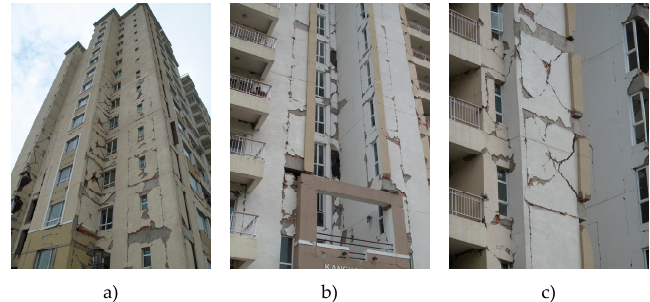
Figure 1. Fourteen-storey reinforced concrete structure damaged after the Gorkha earthquake: a ) distribution of the damages from the first to the seventh storey; b ) detachment of the walls from the envelope frame; c ) diagonal cracking with slight out-of-plane detachment of the wall.